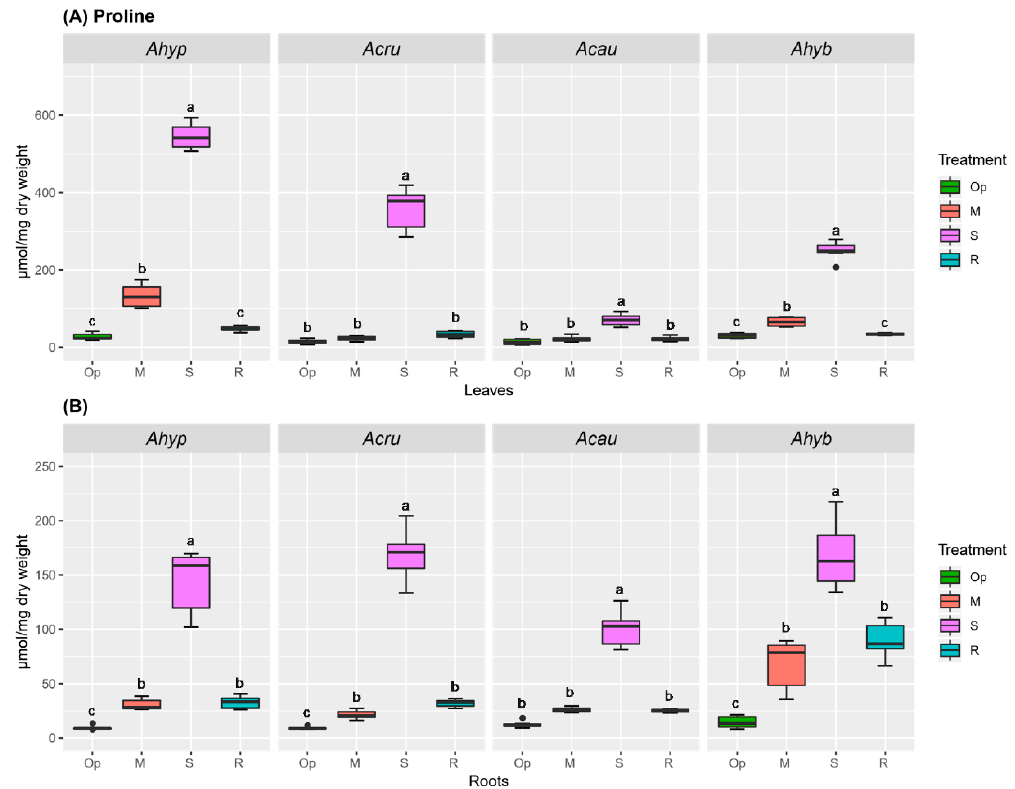
Figure 10. Proline (Pro) accumulation in amaranth plants subjected to water-deficit stress. Pro content in ( A ) leaves and ( B ) roots of Amaranthus hypochondriacus (Ahypo), A. cruentus (Acru), A. caudatus (Acau) and A. hybridus (Ahyb] plants growing in optimal conditions (Op), subjected to moderate (M) or severe (S) water deficit stress, or allowed to recover from S, 1 day after normal watering was restored (R). Di ff erent letters over the box-and-whisker plots represent statistically significant di ff erences at p ≤ 0.05 (Tukey Kramer test; n = 9). Box-and-whisker plots show high, low, and median values. The results shown are those obtained from a representative experiment that was repeated in the spring-summer and summer-autumn seasons of 2015, respectively, with similar results.